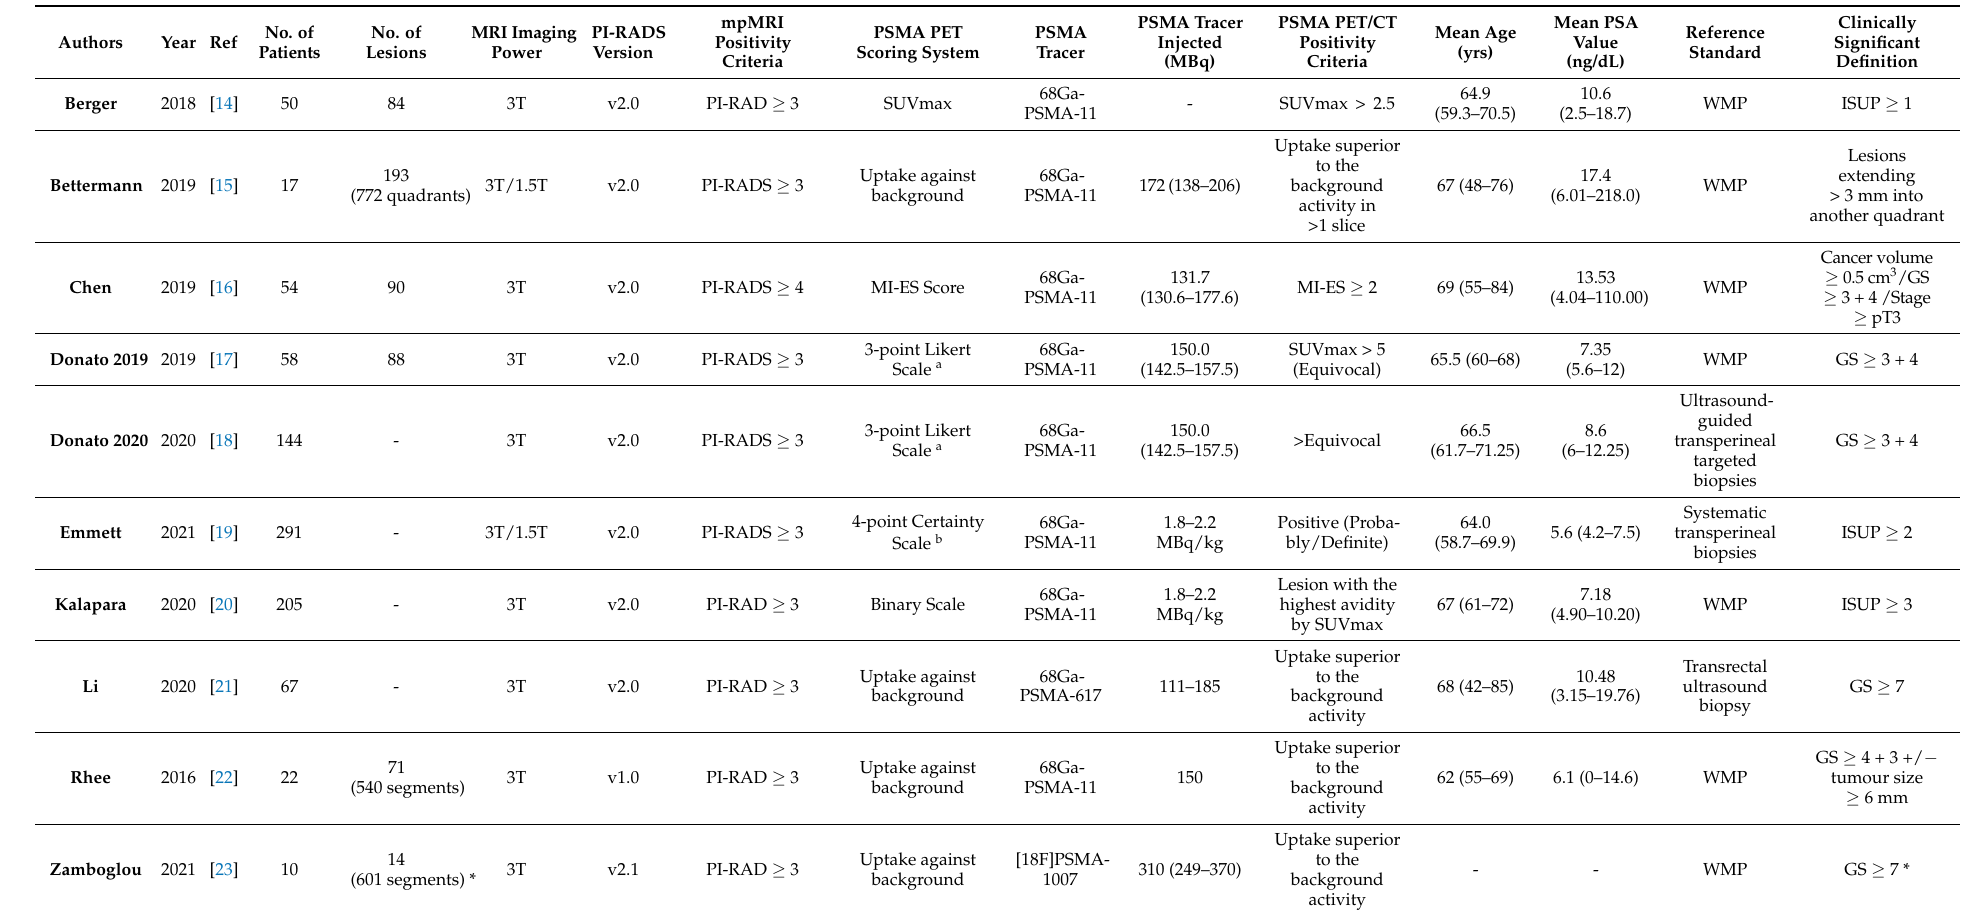
Table 1. Overview of studies included for both per-patient and per-lesion